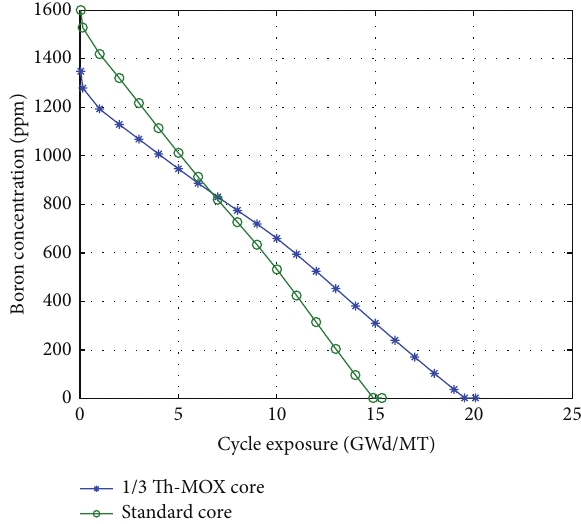
Figure 10: The boron concentration as function of burnup in both of the